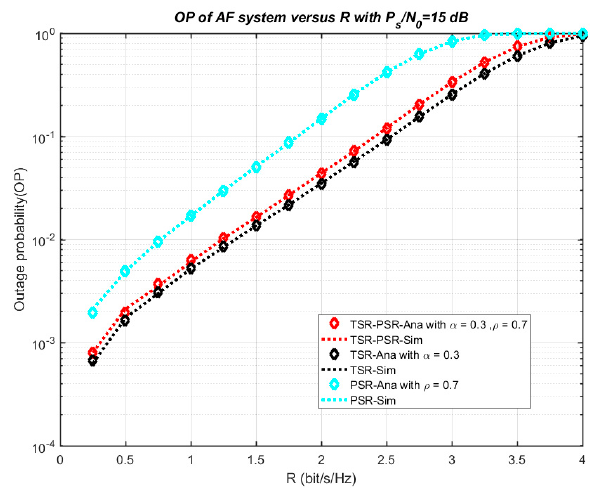
Figure 6. Outage probability versus R.